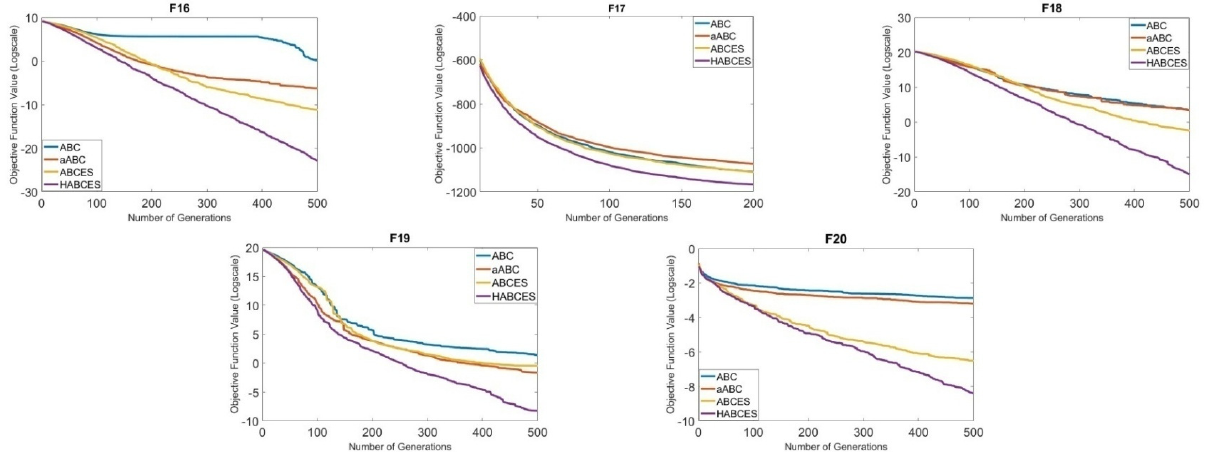
Figure 2. Comparison of the convergences of the ABC, aABC, ABCES and HABCES algorithms when solving high-dimensional global optimization problems (F16–F20).